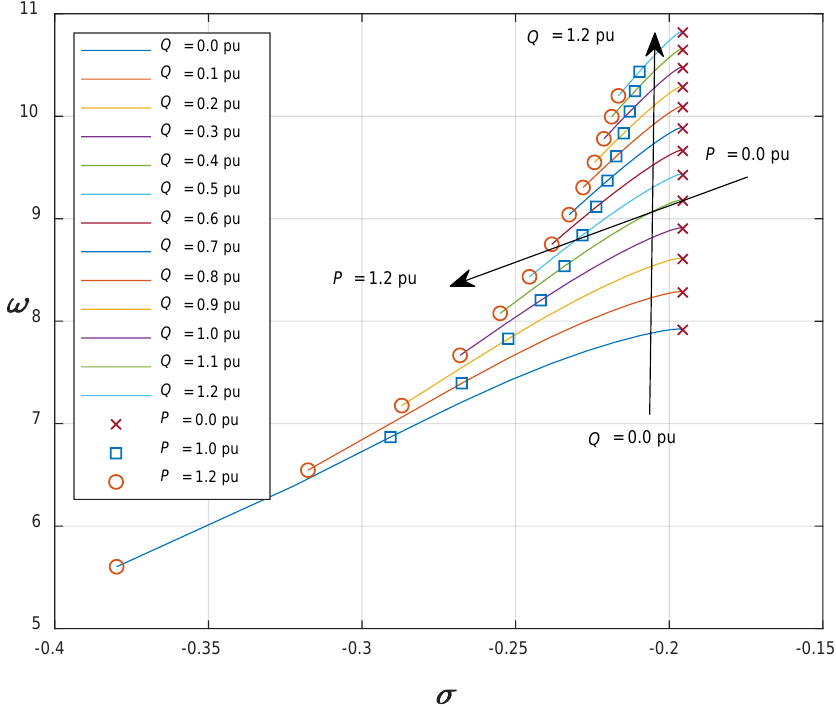
Figure 1. Eigenvalue loci of local mode of 9-MVA hydro-type synchronous generator without AVR.